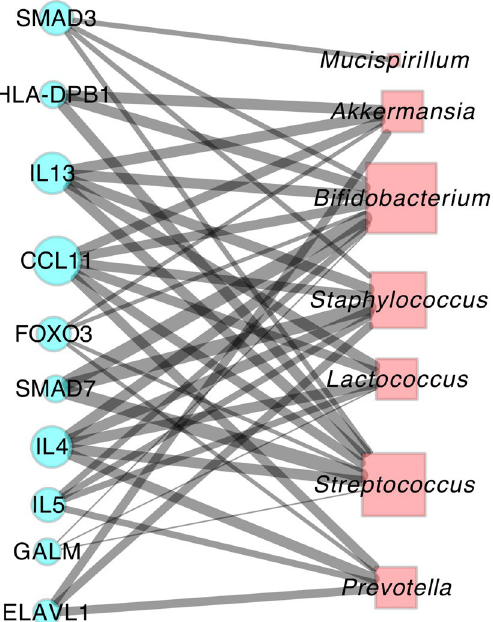
Figure 4. Bipartite graph visualizing the enriched mammalian genes with their associated DA microbes in IL-1α-KO versus WT mice 8 days after DSS-administration. Genes are charted as blue round nodes whereas DA microbes are plotted as red squares. The sizes of the nodes are proportional to the degree in the bipartite graph whereas the width of the edges indicates the strength of the enrichment measured by combined scores from the MSEA algorithm.